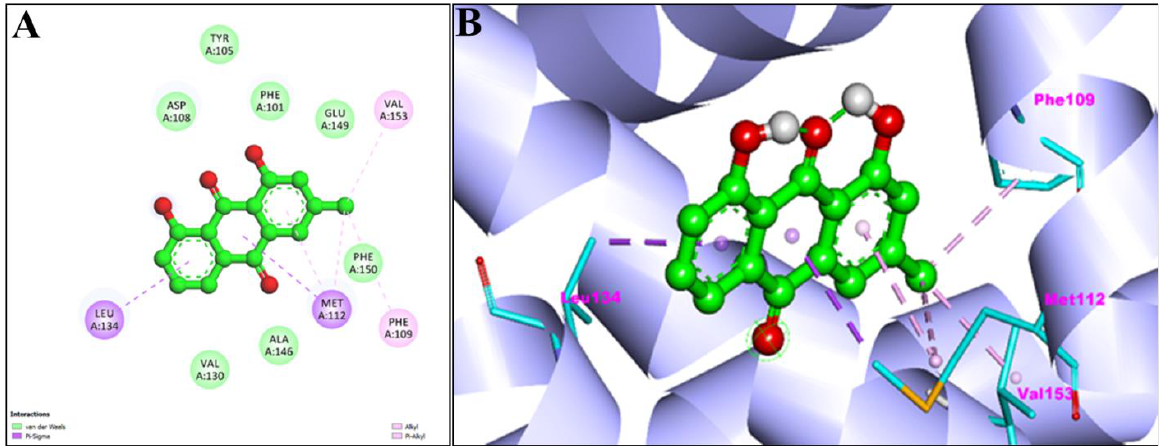
Figure 8. 2D ( A ) and 3D ( B ) representation of interaction of chrysophanol (green color) and apoptosis regulator Bcl-2 (purple color with ribbon pattern) (PDB:4MAN).